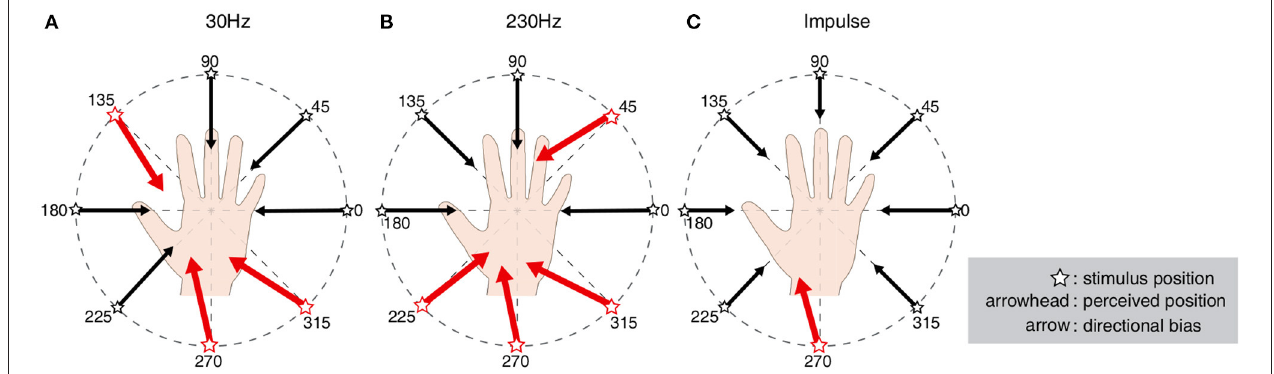
FIGURE 8 | (A) Schematic diagram in the case of 30 Hz. (B) Schematic diagram in the case of 230 Hz. (C) Schematic diagram in the case of impulse. The Red arrows indicate that the directional bias was significant. The diagram of (C) was created based on the information in the paper (Ujitoko et al.,